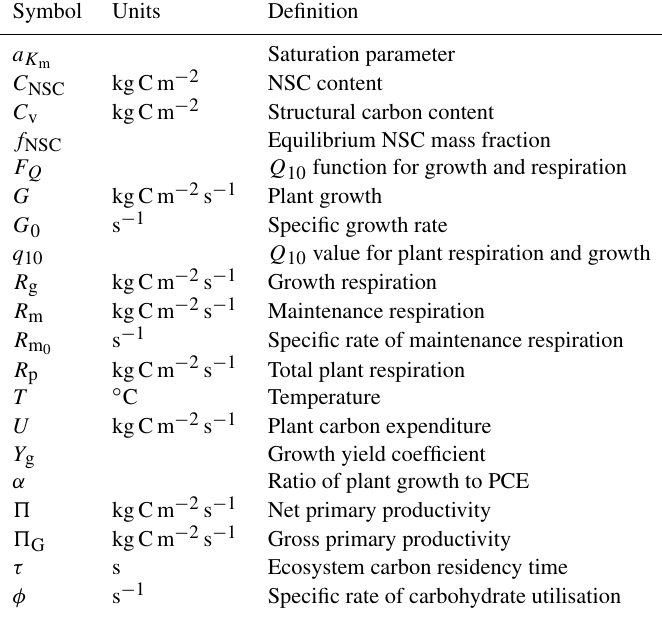
Table B1. Definitions of